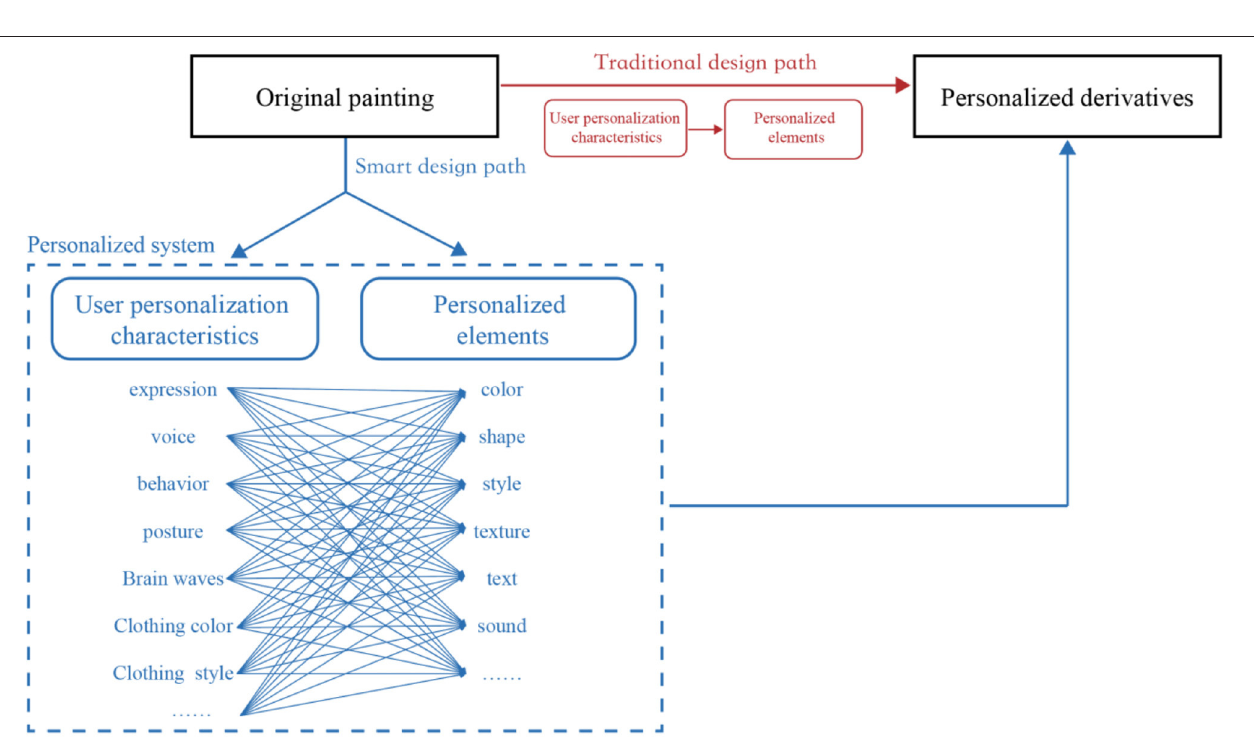
Frontiers in Psychology |